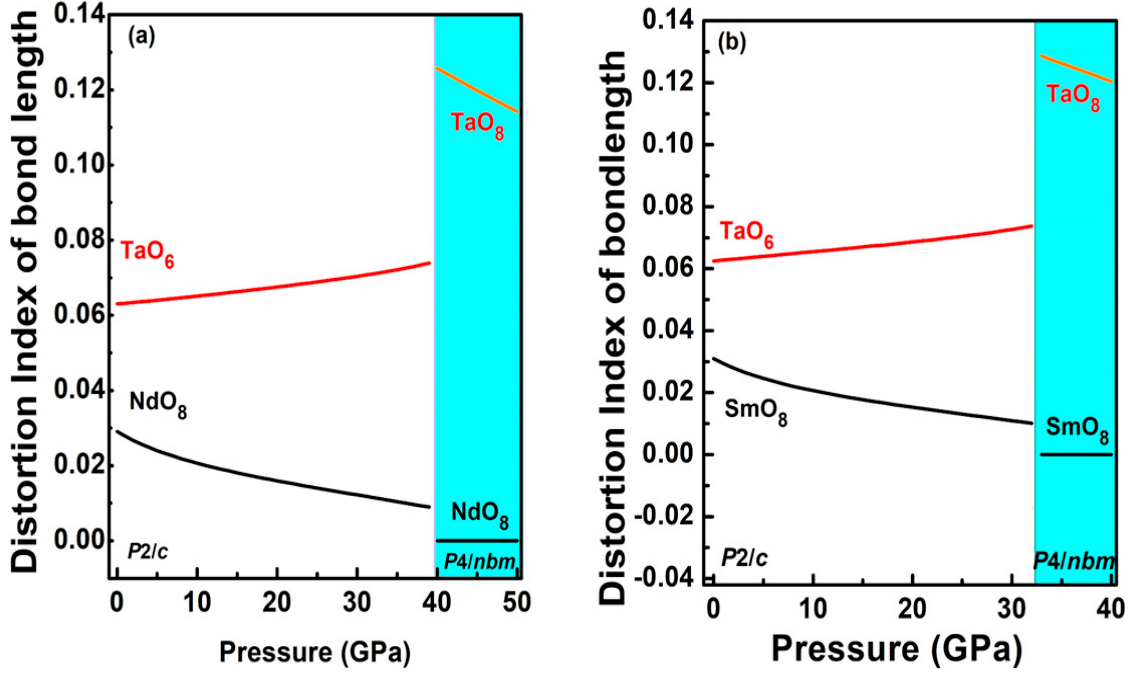
Figure 6. Pressure dependence of the distortion index of the bond length of NdO 8 and SmO 8 (black), TaO 6 (red) and TaO 8 (orange) for the compounds ( a ) NdTaO 4 and ( b ) SmTaO 4 , of the low-pressure phase (white region) and the high-pressure phase (colored region).